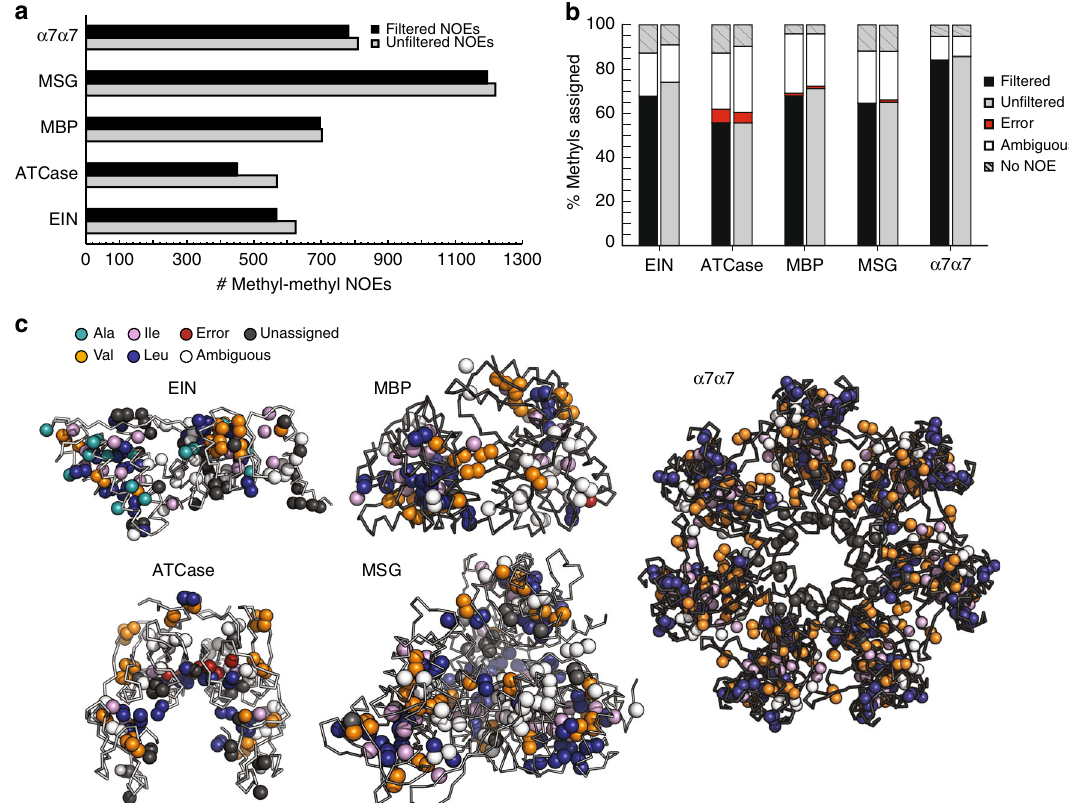
Fig. 2 MethylFLYA performance on the benchmark. a Number of methyl – methyl NOEs before and after fi ltering of manually picked NOESY peak lists (see Results, Benchmark data). b MethylFLYA performance on fi ltered (black) and “ raw ” (un fi ltered) manually picked NOESY peak lists (gray). c Methyl groups assigned as strong (con fi dent) by MethylFLYA with fi ltered NOESY peak lists are indicated with colored spheres in the 3D structures of the benchmark proteins. The colors indicate the amino-acid types of the assigned groups, with non-assigned groups colored